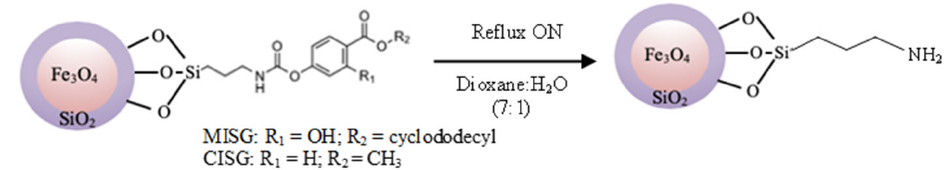
Figure 4. Reaction scheme for the elimination of the template molecule.